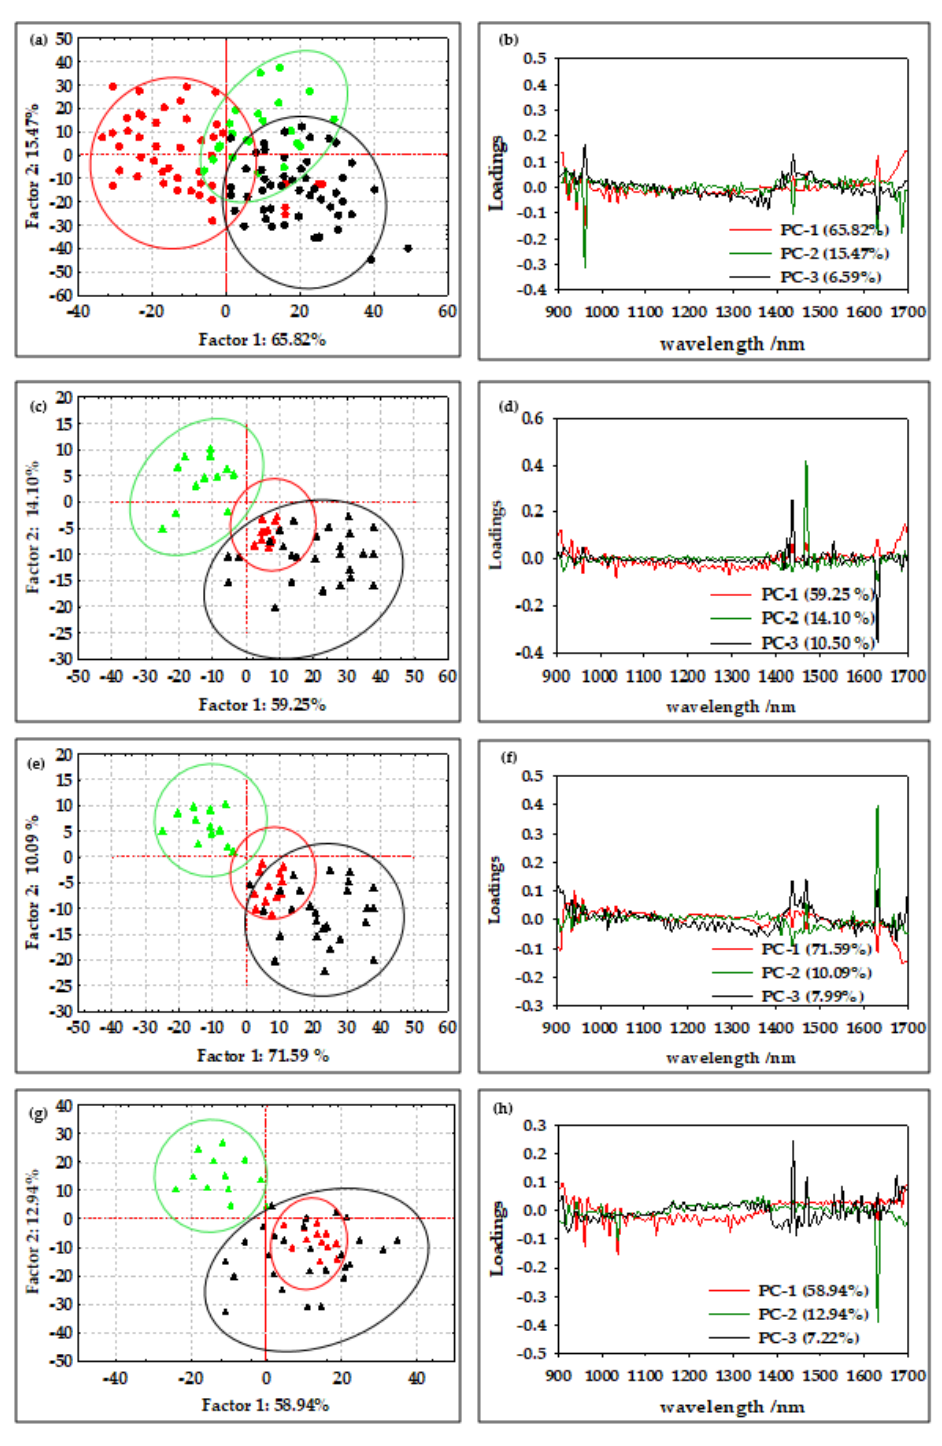
Figure 5. ( a ) PCA score plot of all average oil-in-aqueous mint extract emulsion NIR spectra after MSC preprocessing ( • PEG 1500, • PEG 6000, • PEG 20,000). ( b ) PCA loading of all average oil-in- aqueous mint extract emulsion NIR spectra after MSC preprocessing. PCA score plot of NIR spectra of oil-in-aqueous mint extract emulsion NIR spectra after SNV preprocessing with ( c ) PEG 1500, ( e ) PEG 6000, and ( g ) PEG 20,000 ( 2% emulsifier, 4% emulsifier, 6% emulsifier). PCA load- ing of NIR spectra of oil-in-aqueous mint extract emulsion NIR spectra after SNV preprocessing with ( d ) PEG 1500, ( f ) PEG 6000, and ( h ) PEG 20,000.